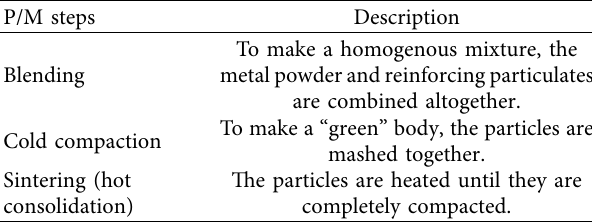
Table 9: Basic powder metallurgy processing steps [123,